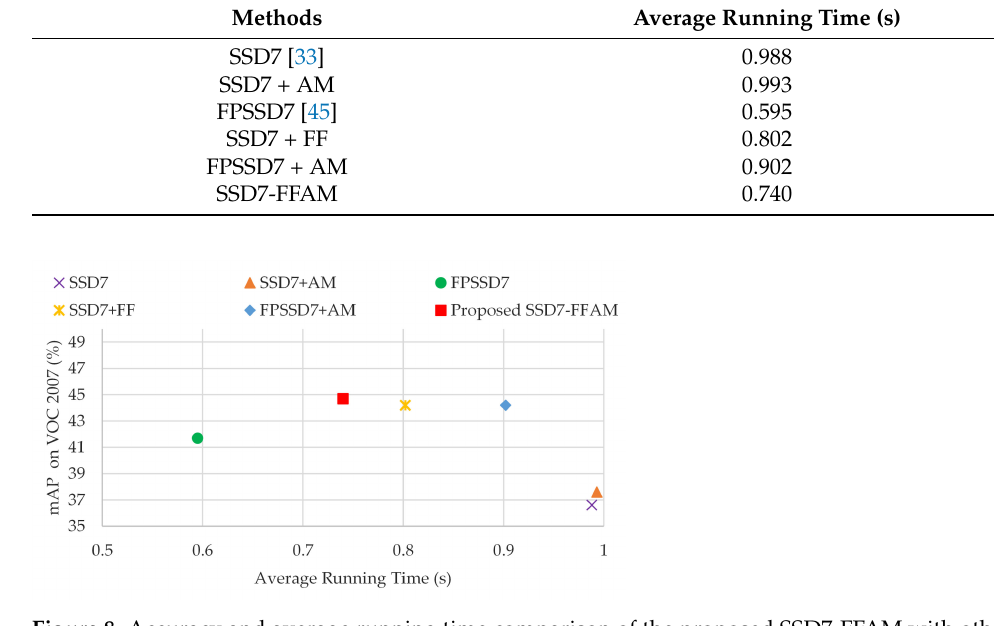
Figure 8. Accuracy and average running time comparison of the proposed SSD7-FFAM with other methods on the Pascal VOC 2007 test set. SSD7-FFAM is more accurate compared with other models with little compromise on